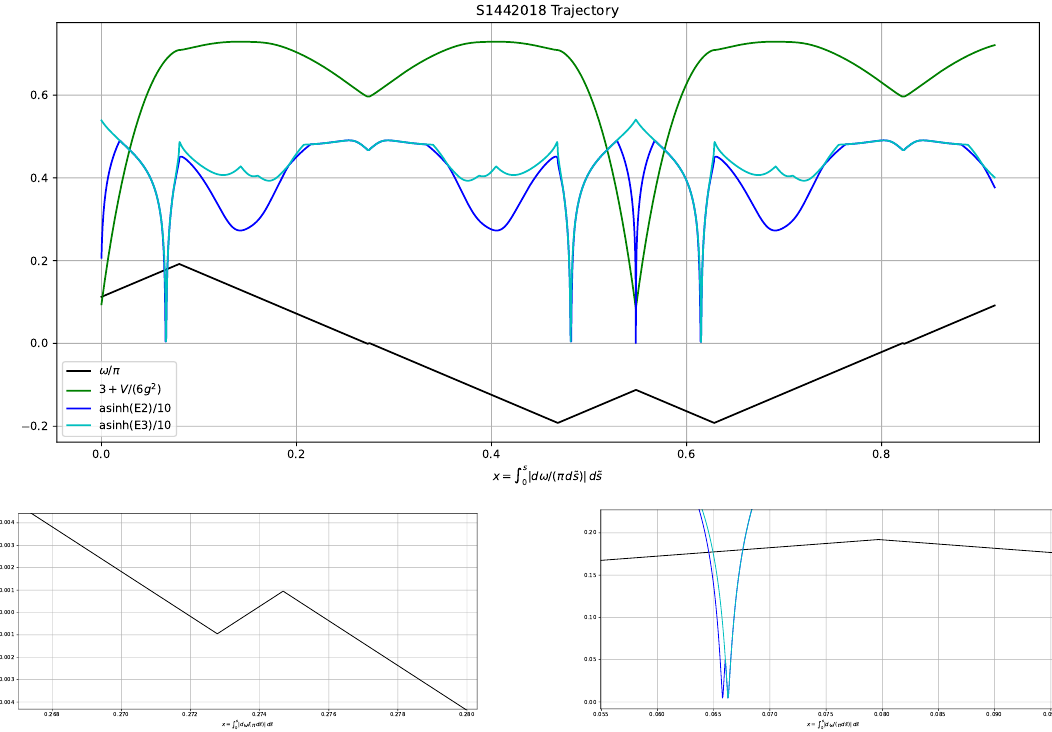
Figure 2. ω -deformation of the S1442018 equilibrium of the de Wit-Nicolai model.